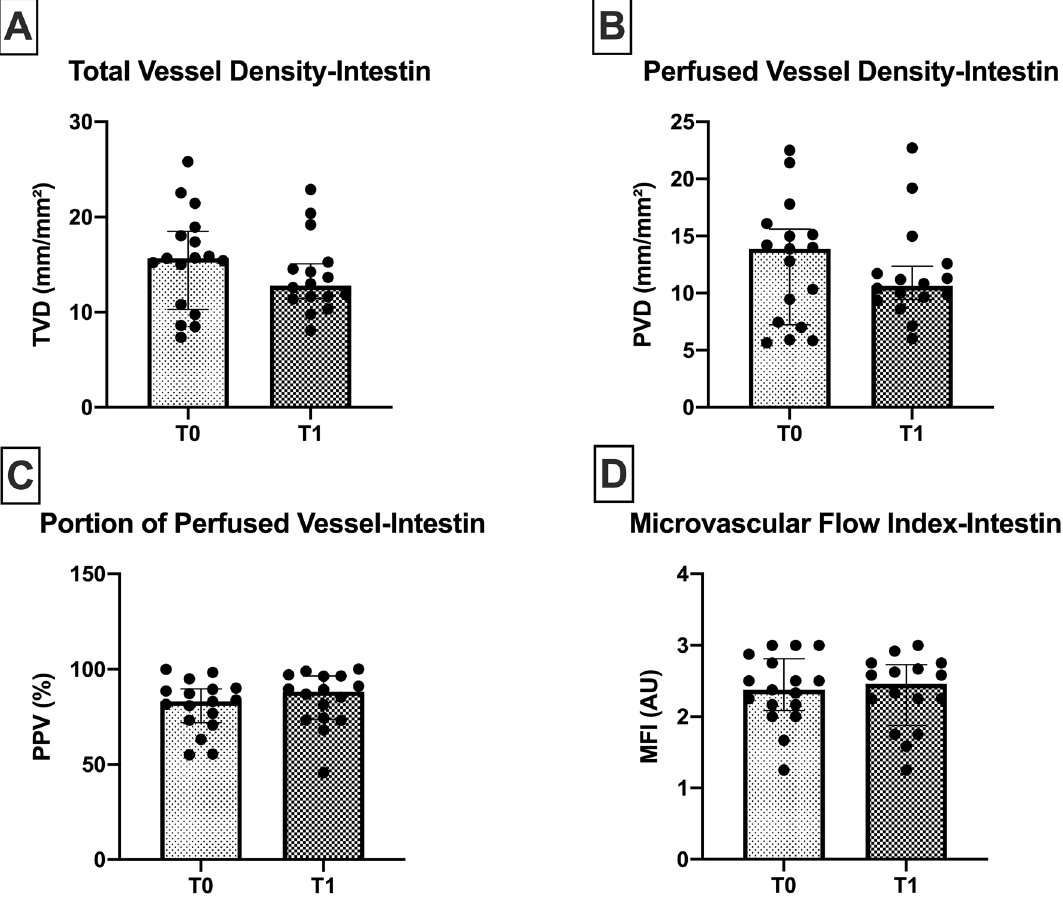
Figure 3. Intestinal microcirculation. Intestinal microcirculatory parameters at the beginning of surgery (T0) and end of surgery (T1) in 18 patients. No significant differences were observed in microcirculatory density nor flow in the perioperative period. TVD; total vessel density. PVD; perfused vessel density. PPV; portion of perfused vessel. MFI; microvascular flow index. Values are represented as median [interquatile] for PVD and PPV and mean ± SD for TVD and